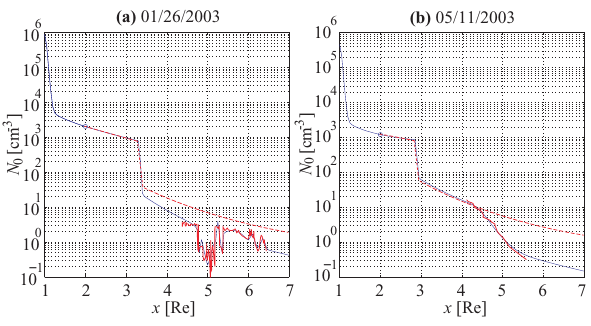
Fig. 4. Electron density profiles derived from the WHISPER elec- tric field measurements for the two dates studied. These are con- structed from direct measurement of the plasma frequency using WHISPER data at different magnetic latitudes and then projected to the equator, assuming an R − 4 variation of the electron density with radial distance from the Earth. (a) Profile for 26 January 2003. (b) Profile for 11 May 2003. The red full line is the electron den- sity measured, while the red dashed line is the model. The blue line represents the actual electron density profile used in the